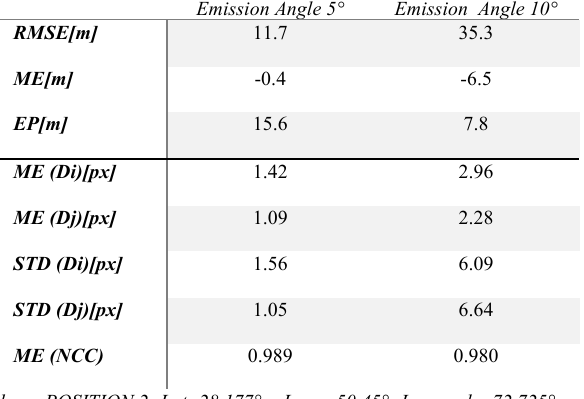
Table 1 (a, b, c, d): HRIC Summary Results